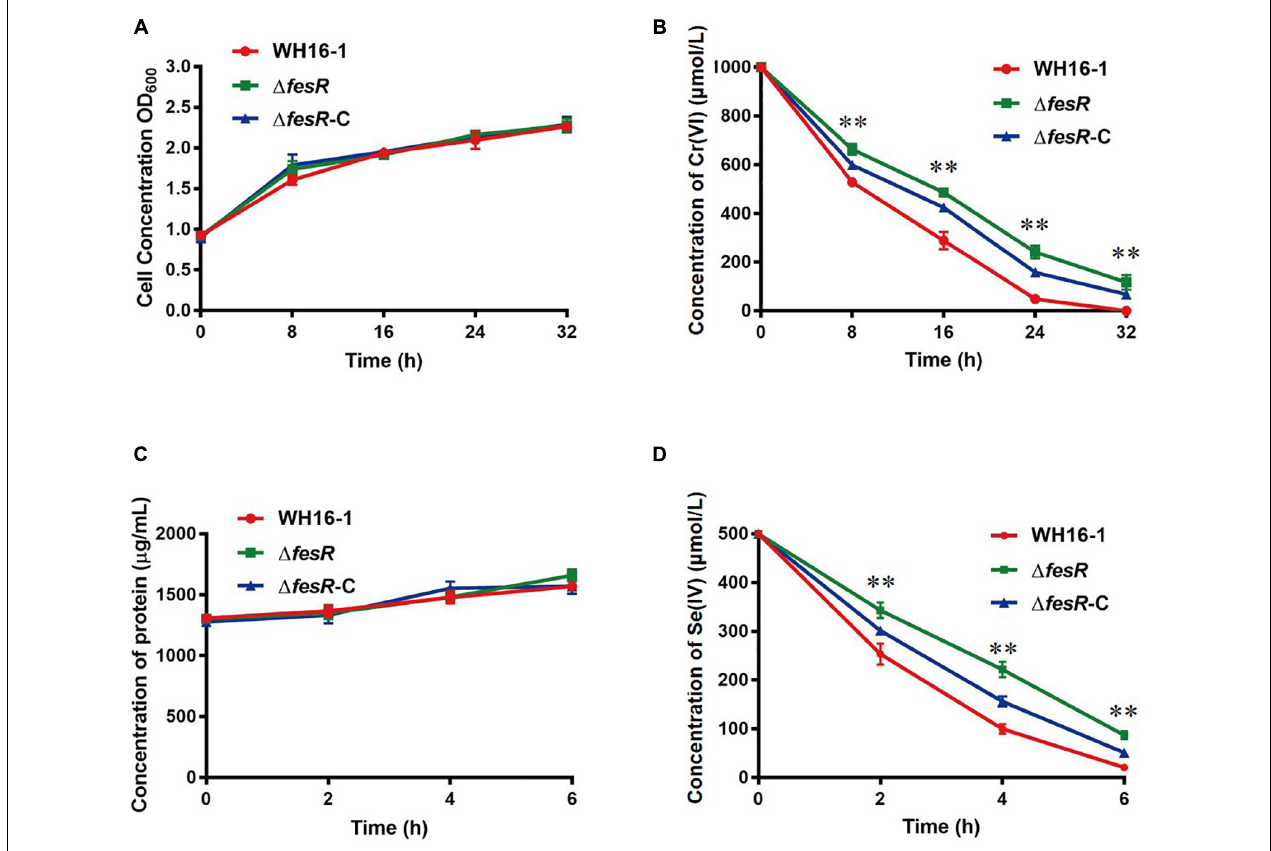
FIGURE 3 | FesR is involved in the Cr(VI) and Se(IV) reduction in Alishewanella sp. WH16-1. Growth curves of WH16-1 (wild type), (cid:49) fesR (mutant) and (cid:49) fesR -C (complementation) strains in Luria-Bertani (LB) medium with 1000 µ mol/L K 2 CrO 4 (A) and 500 µ mol/L Na 2 SeO 3 (C) , respectively. Reduction curves of WH16-1, (cid:49) fesR and (cid:49) fesR -C in LB medium with 1000 µ mol/L K 2 CrO 4 (B) and 500 µ mol/L Na 2 SeO 3 (D) , respectively. The values represent averages and standard deviations (SD) of three replicates. ∗∗ stands for the statistically highly significant as p < 0.001 between the wild type and mutant